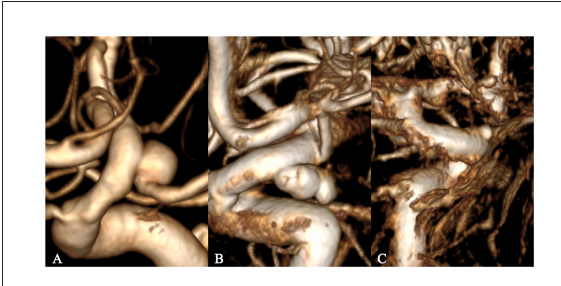
FIGURE1 Grading of 3D image quality. (A–C) represent excellent, good, and poor grades, respectively. selected, including 48 aneurysms from 66 patients, of which 20 were ruptured.